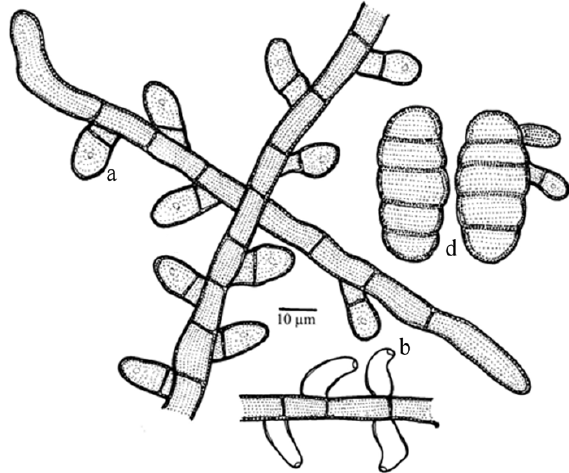
Figure 5. Amazonia syzygii a - Appressorium; b - Phialide; d - Ascospores